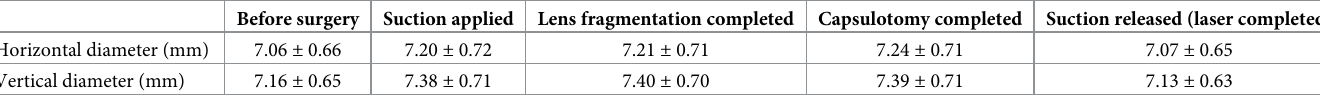
Table 2. Intraoperative pupil diameters at different points in time (mean ± standard